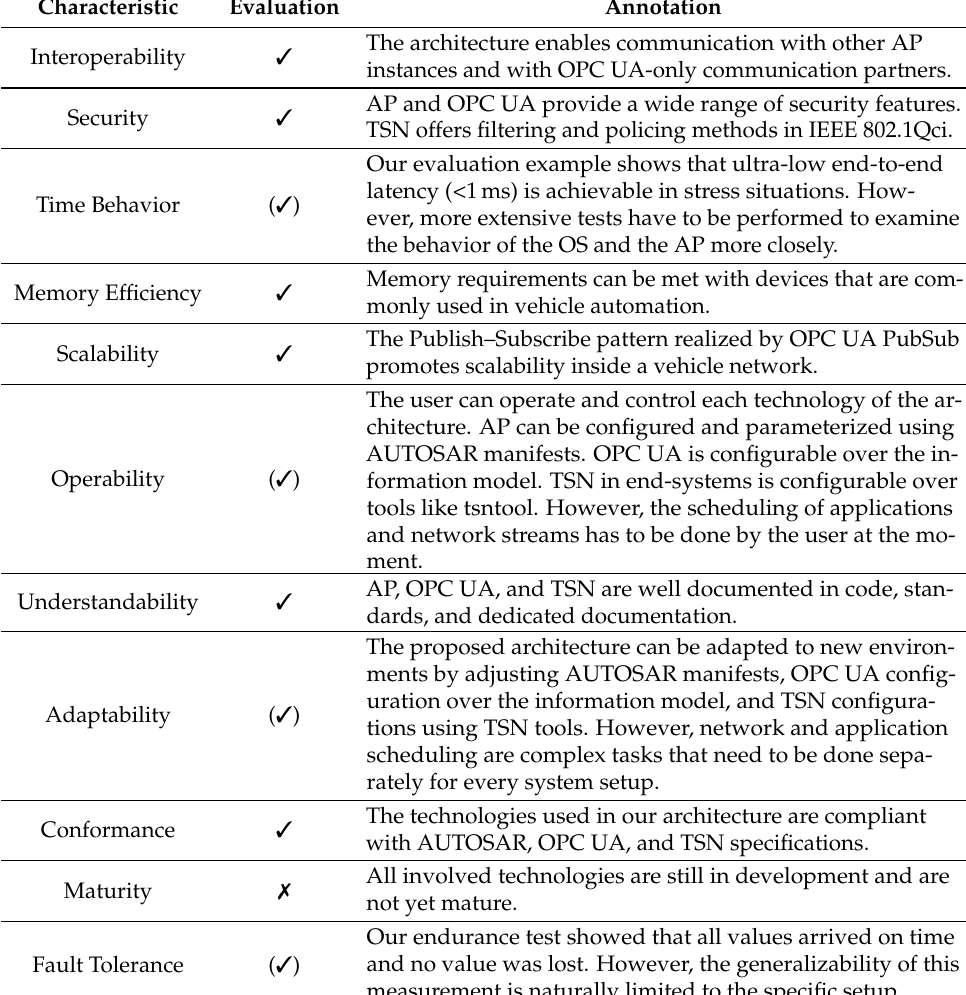
Table 2. Compliance of the proposed architecture with quality characteristics. ( (cid:51) : mostly or fully compliant, ( (cid:51) ): partially compliant, (cid:55) : not